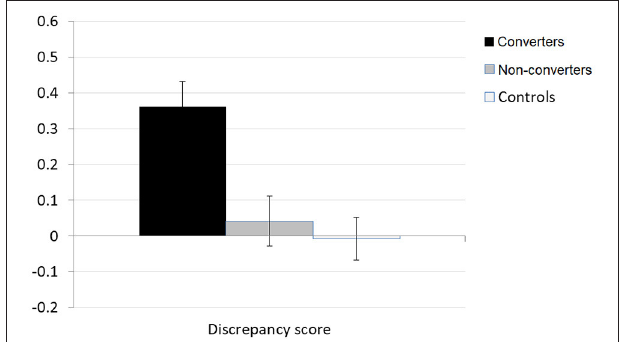
FIGURE 1 | MARS-MFS discrepancy